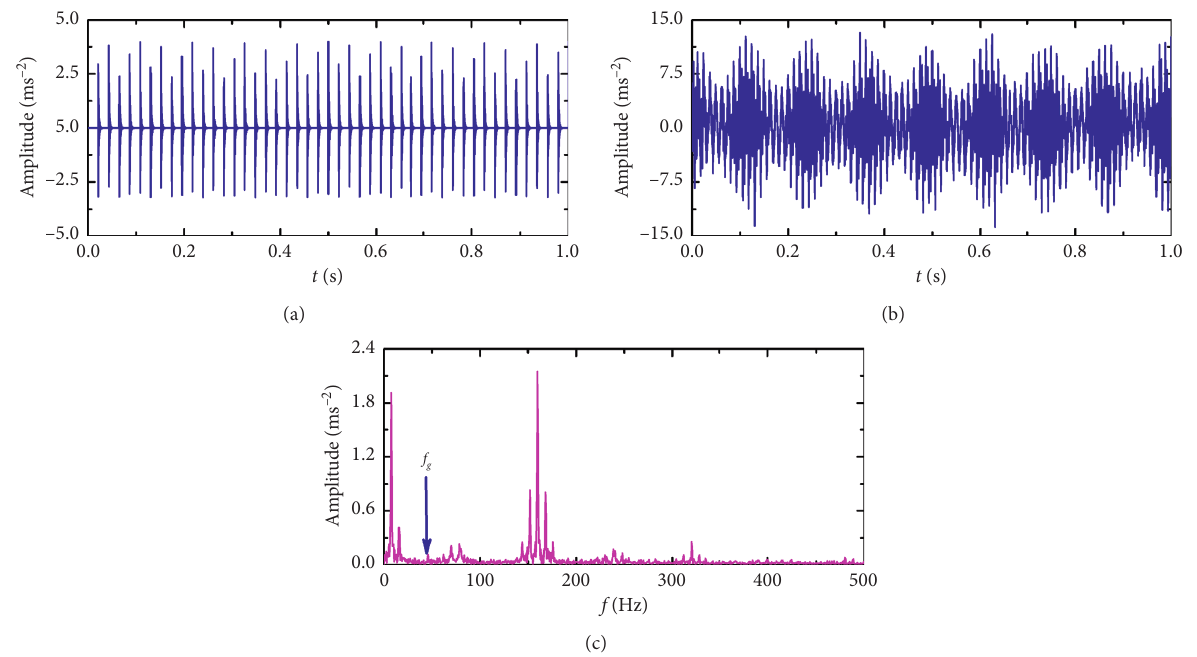
Figure 5: The simulated signal: (a) impulse components I ( t ) , (b) simulated signal x ( t ) , and (c) Hilbert envelope spectrum of x ( t )